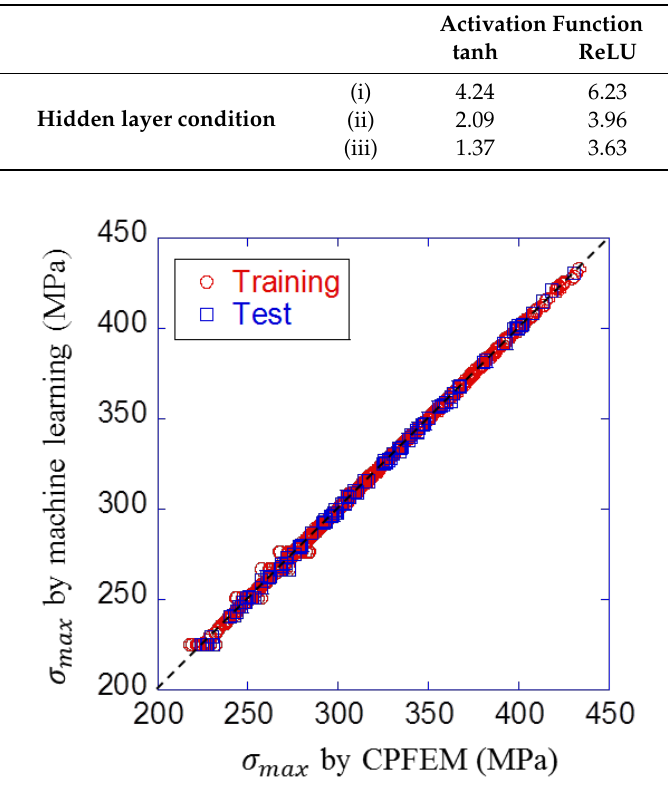
Figure 13. Prediction result of neural network model under the best condition.